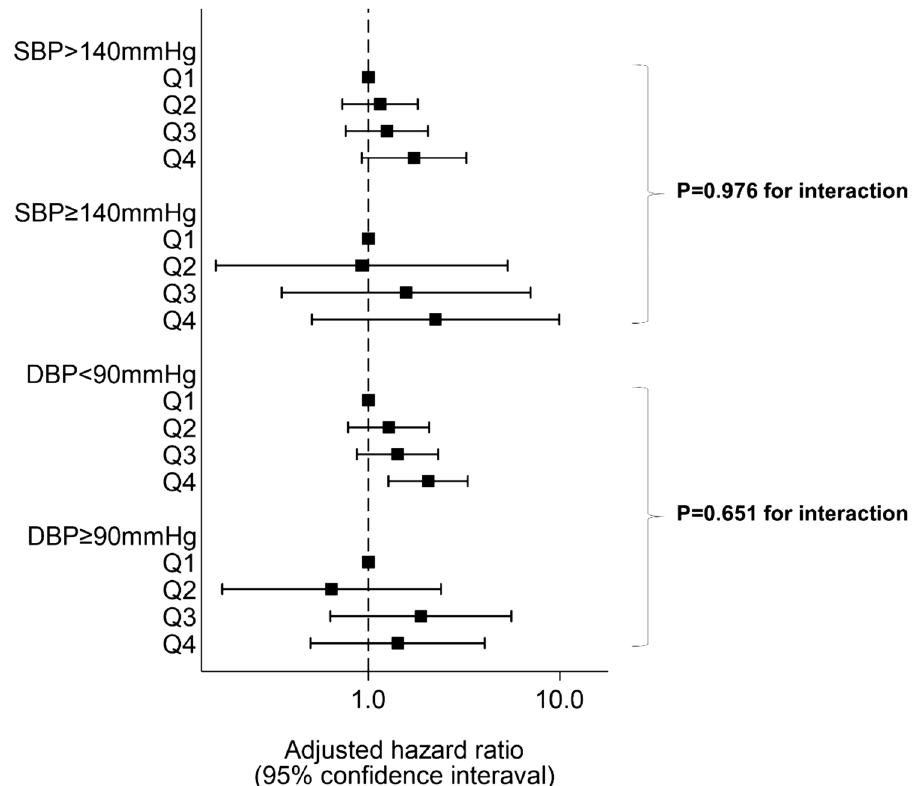
Figure 2. Stratified analyses of blood pressure: relationship between pulse pressure quartile and progression of CKD. Analyses were stratified by SBP (< 140, ≥ 140) and DBP (< 90, ≥ 90). Adjusted hazard ratios and 95% confidence intervals associated with pulse pressure quartiles for the progression of CKD were obtained, controlling for sex, age, diabetes mellitus, dyslipidemia, hyperuricemia, obesity, current smoking and drinking alcohol, and baseline eGFR and proteinuria. P for interaction was obtained by adding interaction terms to the models. Boxes and vertical lines represent hazard ratios and 95% confident intervals,